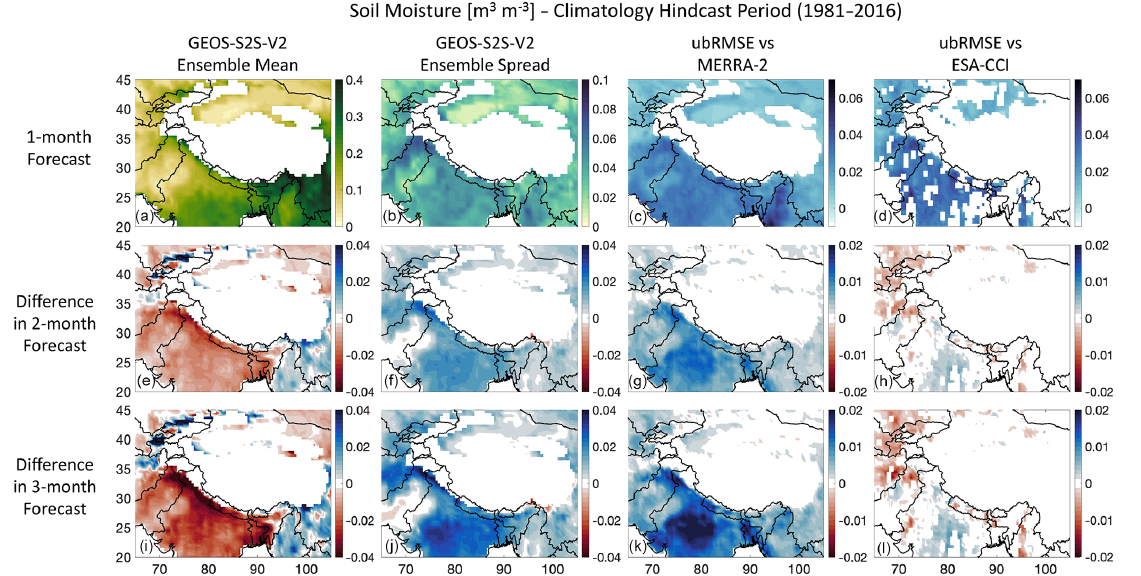
Figure 11. As in Fig. 7, but for soil moisture (SM) in (m 3 m − 3 ) and vs. ESA-CCI in the right column. Grid cells that are masked out (in white) show areas with no-data values. Here, red in the subfigures indicates lower values (i.e., less soil moisture, smaller spread, or smaller error) in the 2- and 3-month forecasts, and blue indicates higher values compared to the 1-month